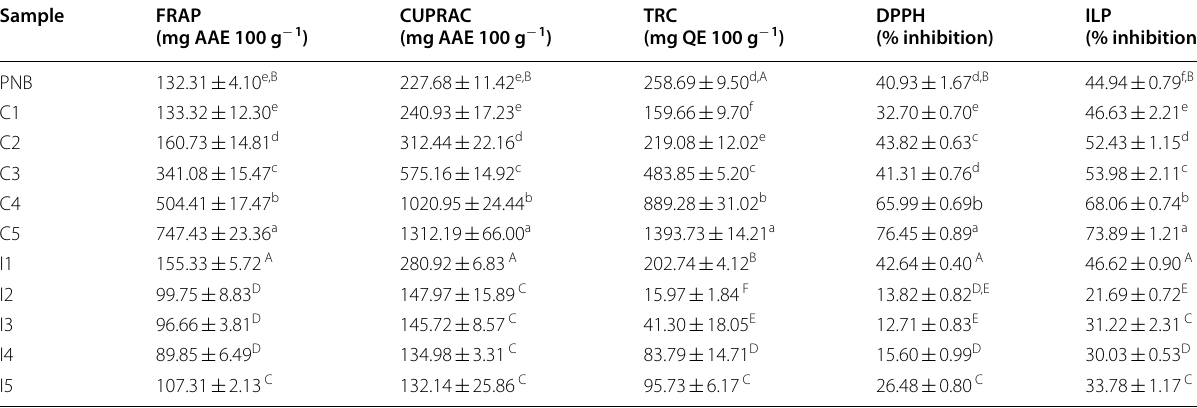
FRAP, ferric reducing antioxidant power; CUPRAC, cupric reducing antioxidant capacity; TRC, total reducing capacity; DPPH, 2,2-Diphenyl-1-picrylhydrazyl, ILP, inhibition of lipid peroxidation; AAE and QE are ascorbic acid and quercetin equivalents, respectively Significant differences ( P < 0.05) between concentrate (C1-C5) and ice (I1-I5) fractions compared to PNB in each column are indicated lowercase and capital letters, respectively